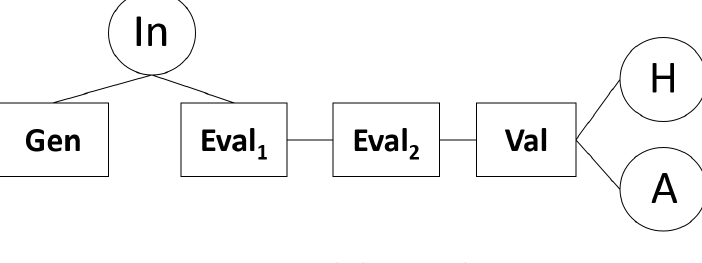
Figure 1. Underlying graph G .